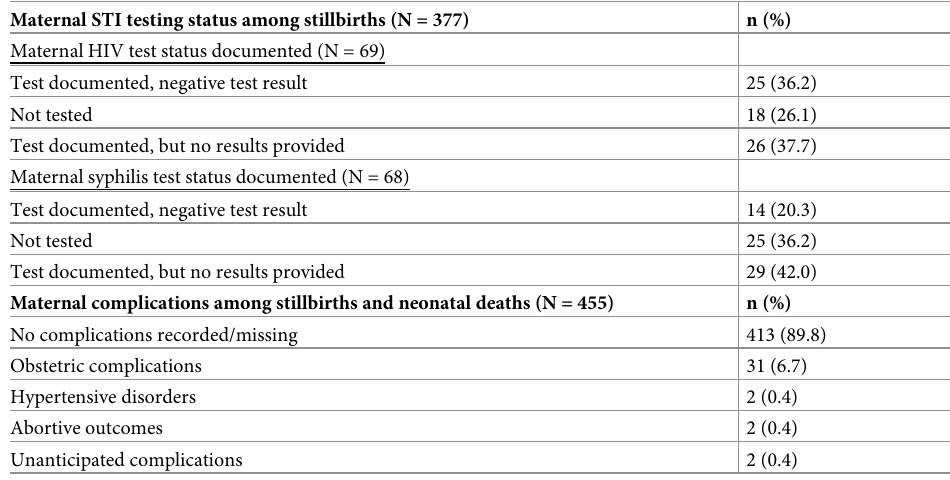
Table 5. Maternal STI testing status and maternal complications identified during register abstraction in two facilities in Nepal. Maternal STI testing status among stillbirths (N =